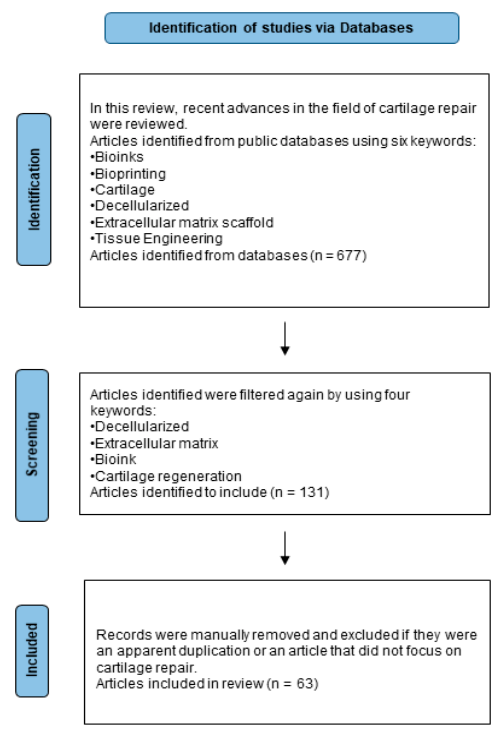
Figure 1. PRISMA flow chart.